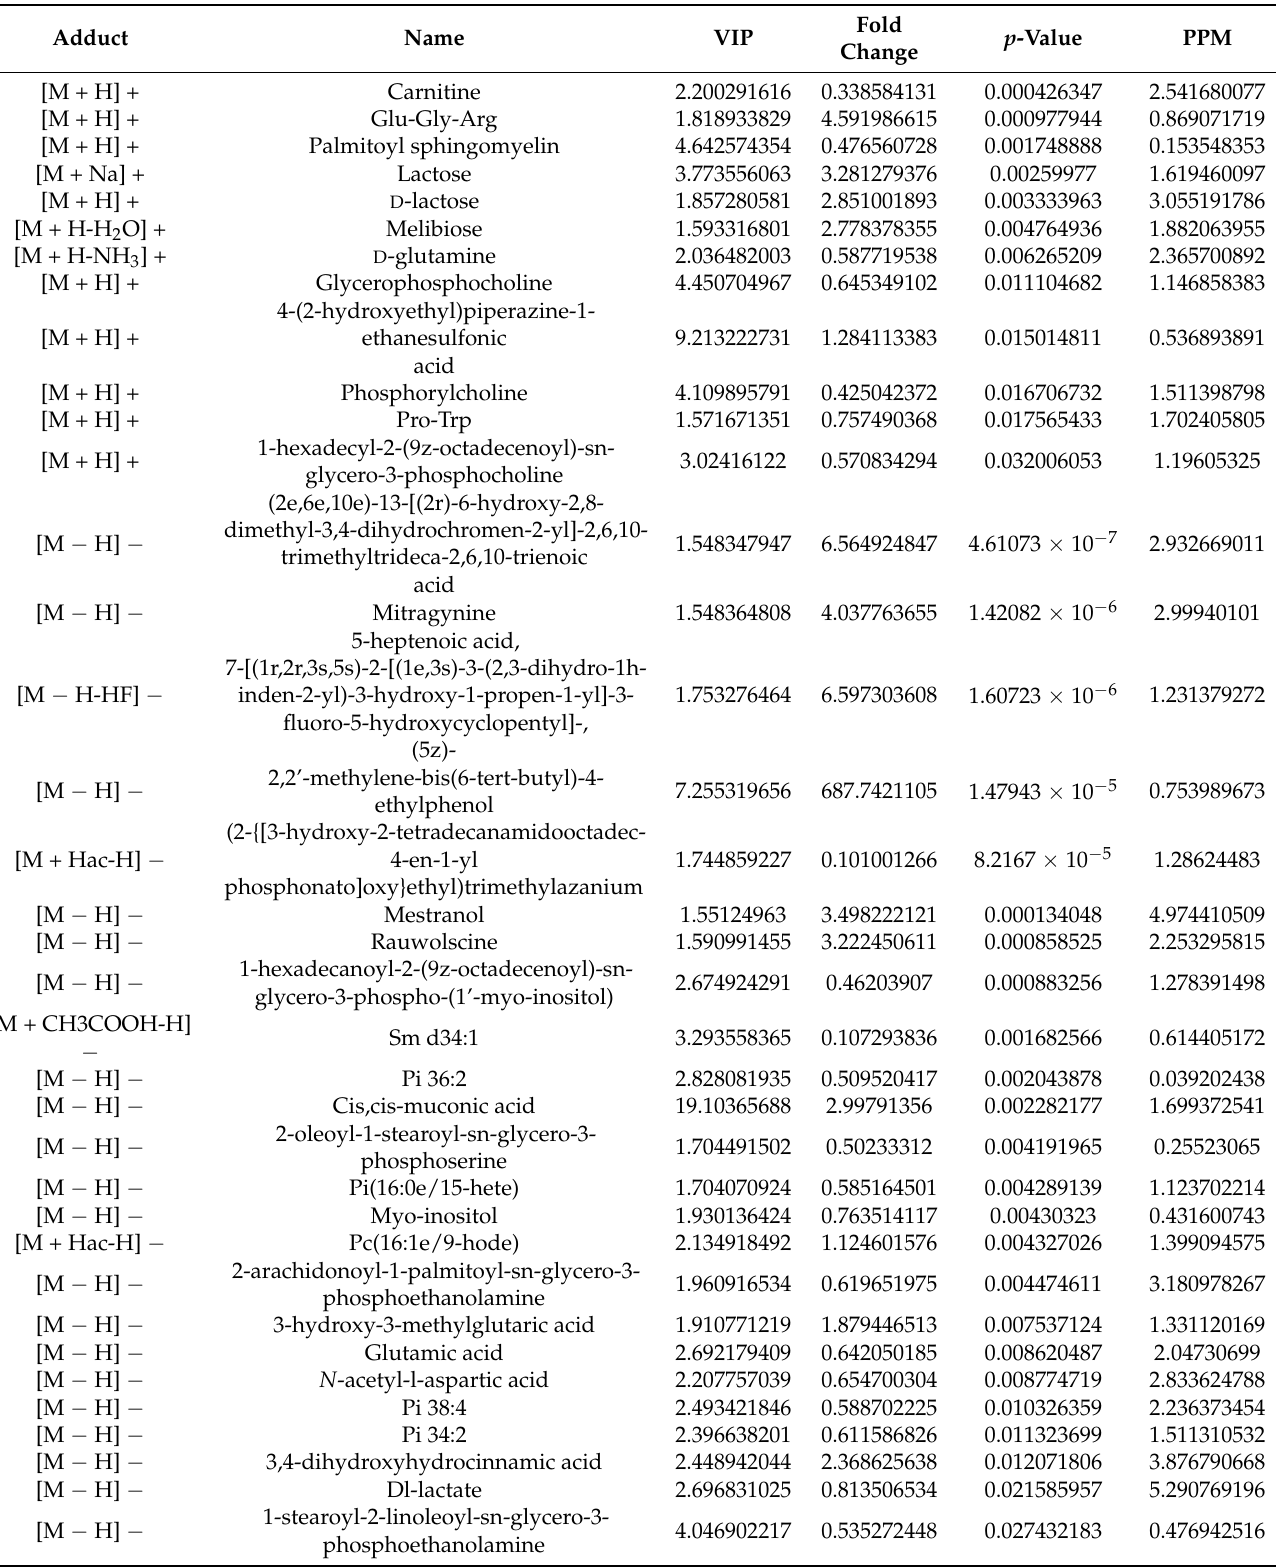
Table 1. Significant differential metabolites identified by untargeted metabolomics